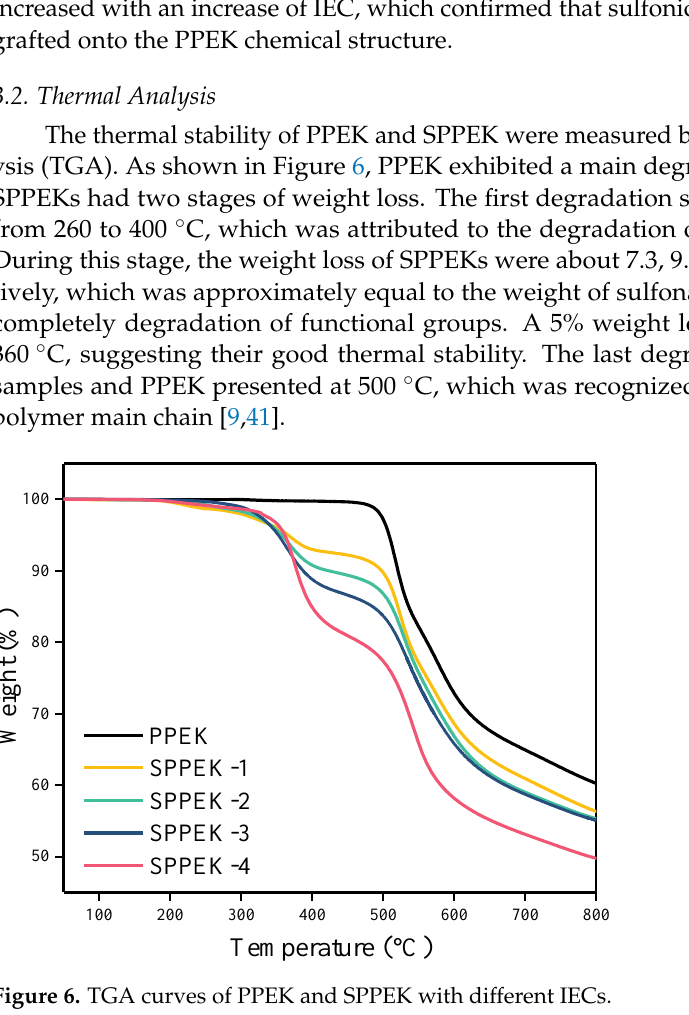
Figure 5. FT-IR spectra of PPEK and SPPEK.